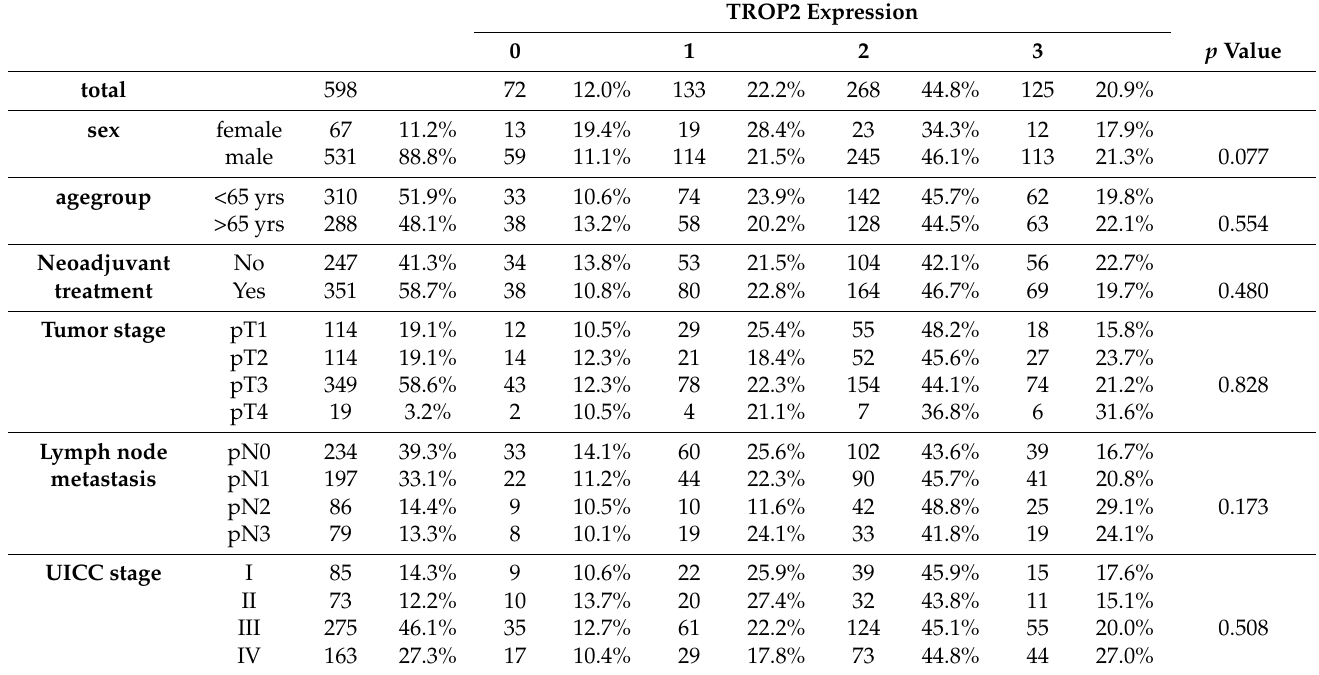
Table 1. The protein expression of TROP2 was determined by immunohistochemistry in 598 patients with operable adenocarcinoma of the esophagus (EAC). 88% of the tumors showed varying degrees of TROP2 positivity (1 weak expression, 3 strong and homogeneous expression). Almost 60% of these tumors were treated neoadjuvantly (according to CROSS or chemotherapy